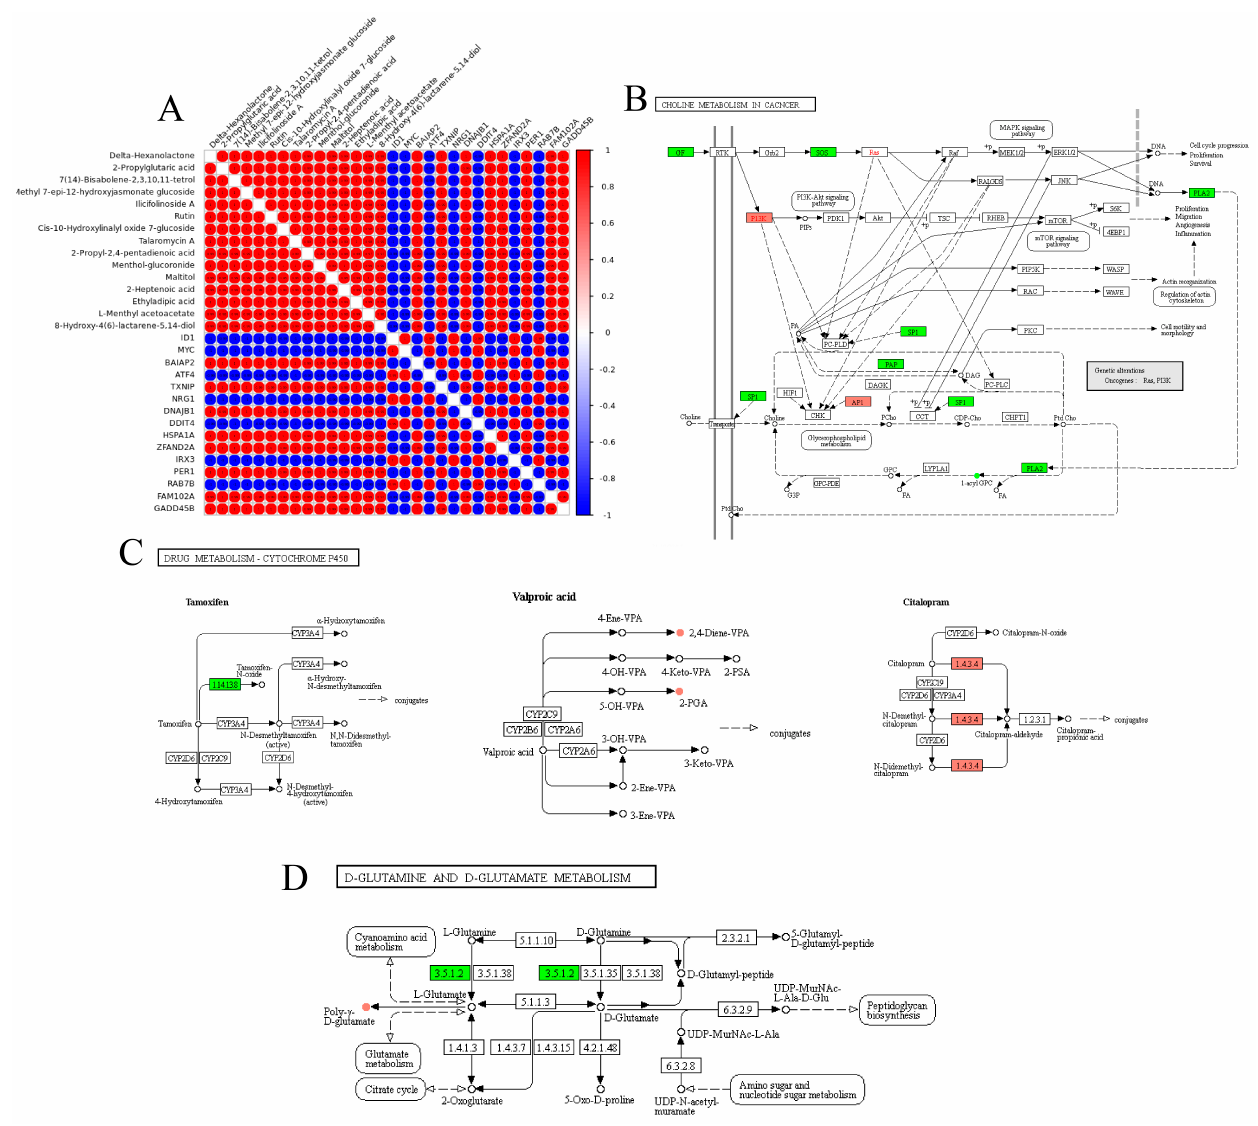
Figure 6. Integrated analysis of the expressions of differentially expressed genes (DEGs) and metabo- lites in control vs. SARA. ( A ) Pearson correlation analysis of the expressions of differentially expressed genes (DEGs) and metabolites (TOP15). Red indicates a positive correlation, blue indicates a negative correlation, and deeper colors indicate stronger correlations. ( B ) Part of choline metabolism in cancer. pathways. The round nodes are metabolites and the square nodes are the enzymes corresponding to the transcripts. The expression fold changes of metabolites from low to high are represented by blue to yellow colors, and the expression fold changes of transcripts from low to high are represented by green to red